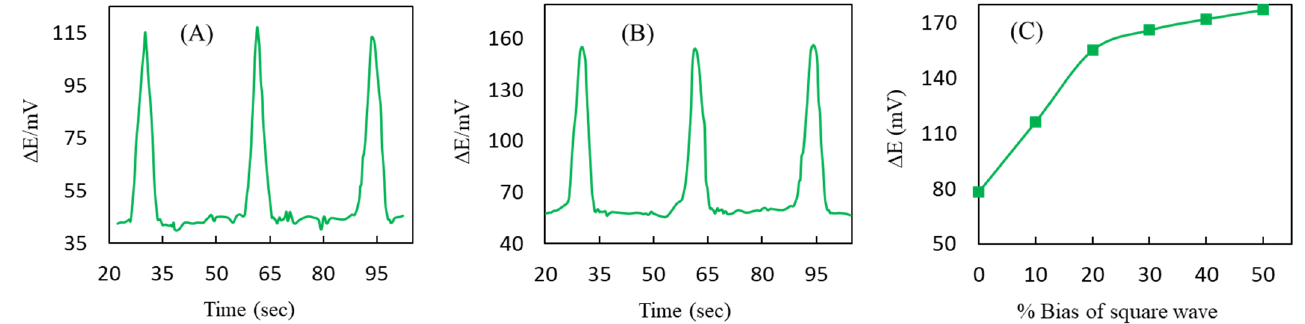
Figure 6. The dependence of SIA-DEP potential peak intensity and shape on the % bias value of SW, in triplicate ( A ) 10% and ( B ) 20%. ( C ) shows the average (n = 3) change of peak intensity with percent bias of the SW. Ascorbic acid concentration is 280.0 µM.